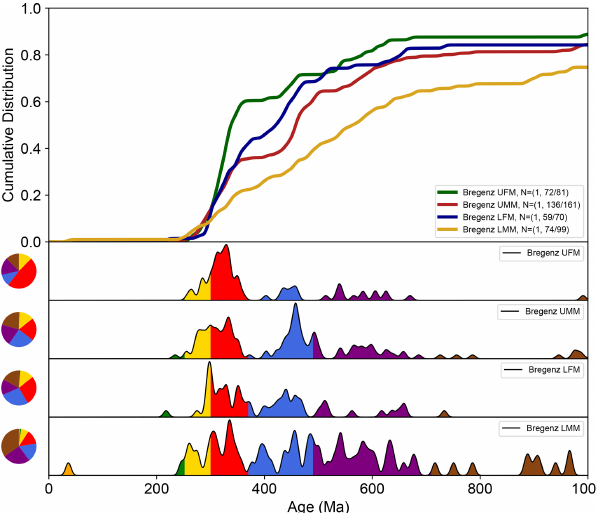
Figure 6. Detrital zircon U–Pb age data from the Bregenz Section (locations of samples depicted in Fig. 3c). See Fig. 4 legend and caption for additional